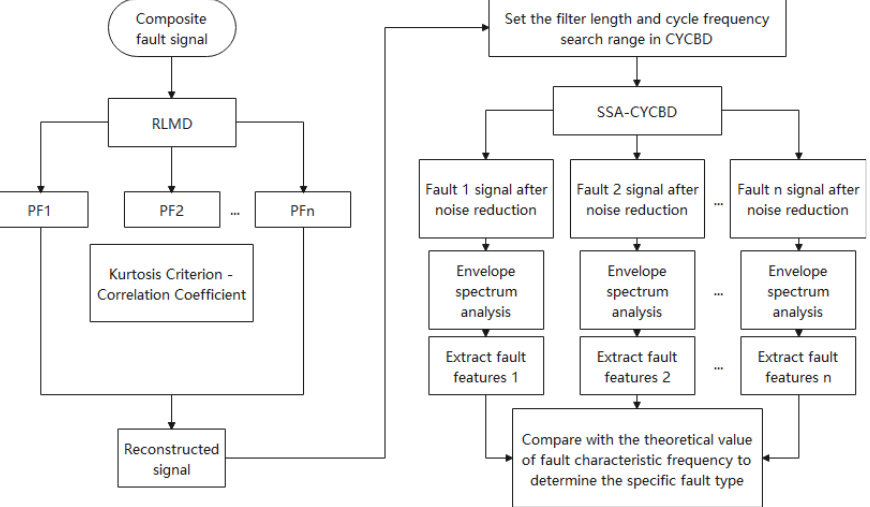
Figure 1. Flow chart of the composite fault diagnosis method combining the RLMD and SSA-CYCBD algorithms.